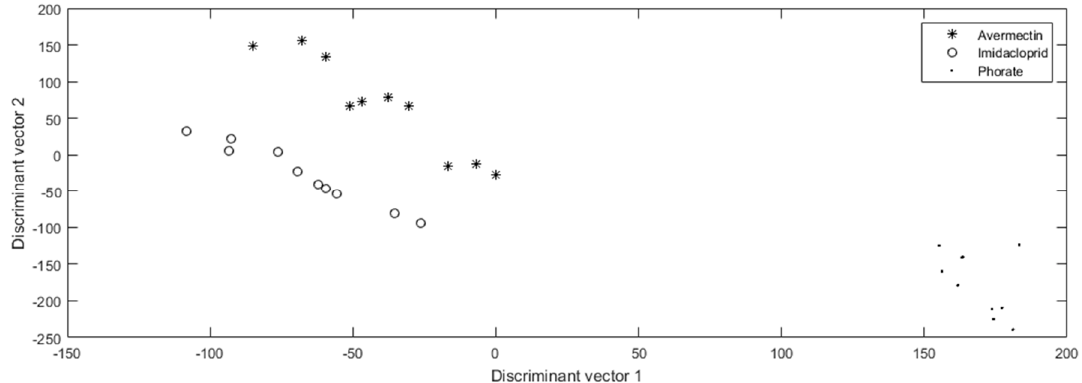
Figure 2. The pesticide identification results of phorate (0.01 mg/Kg), avermectin (0.01 mg/Kg), and imidacloprid (0.5 mg/Kg).